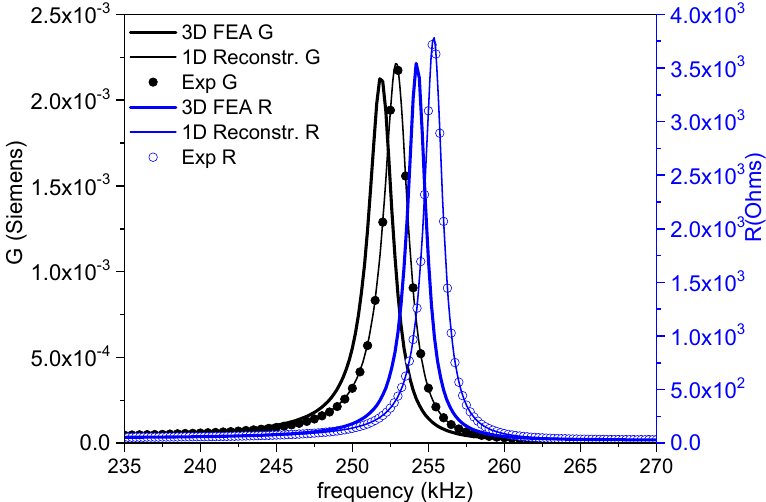
Figure 6. Fundamental radial extensional resonance mode of a thickness-poled and excited thin disk. The FEA-modeled (thick lines) impedance spectrum in an ( R , G ) plot of a disk with a diameter of 12 mm and a thickness of 1.15 mm. The experimental data (symbols) and the reconstructed spectrum after the calculation of the parameters in a 1D model (thin lines) are also shown for comparison. Black symbols and lines (G data) can be read in the left-y-axis, and the blue ones ( R data) are in the